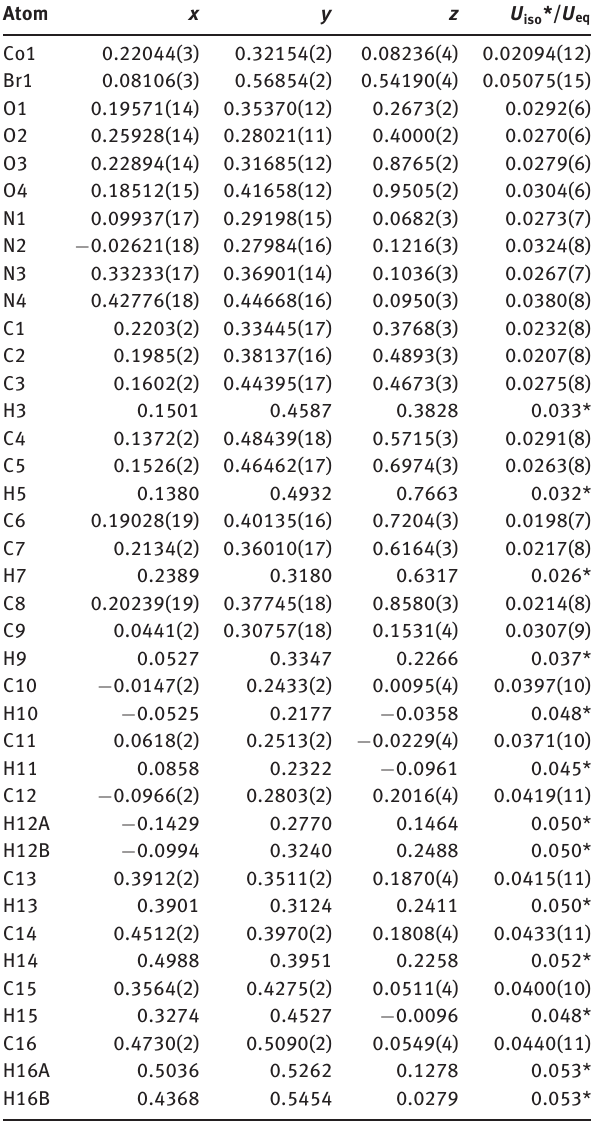
Table 2: Fractional atomic coordinates and isotropic or equivalent isotropic displacement parameters (Å 2